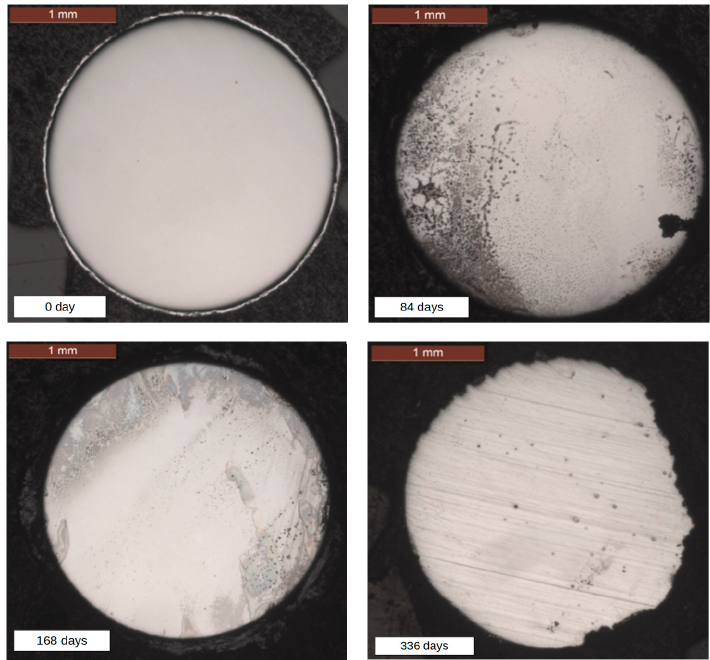
Figure 6. Transverse cross section of a corroded individual steel wire.